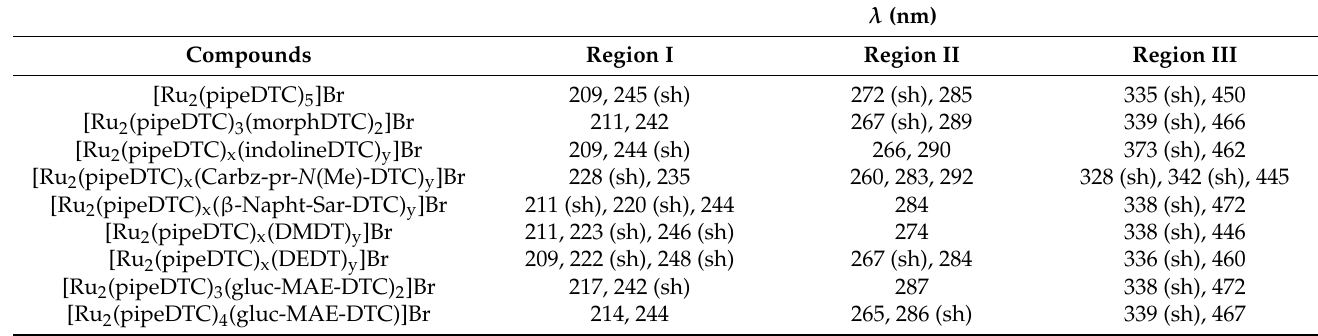
Table 4. Collection of UV-Vis absorption data for the synthesized binuclear ruthenium dithiocarba- mate complexes in each of the three regions absorption (sh: